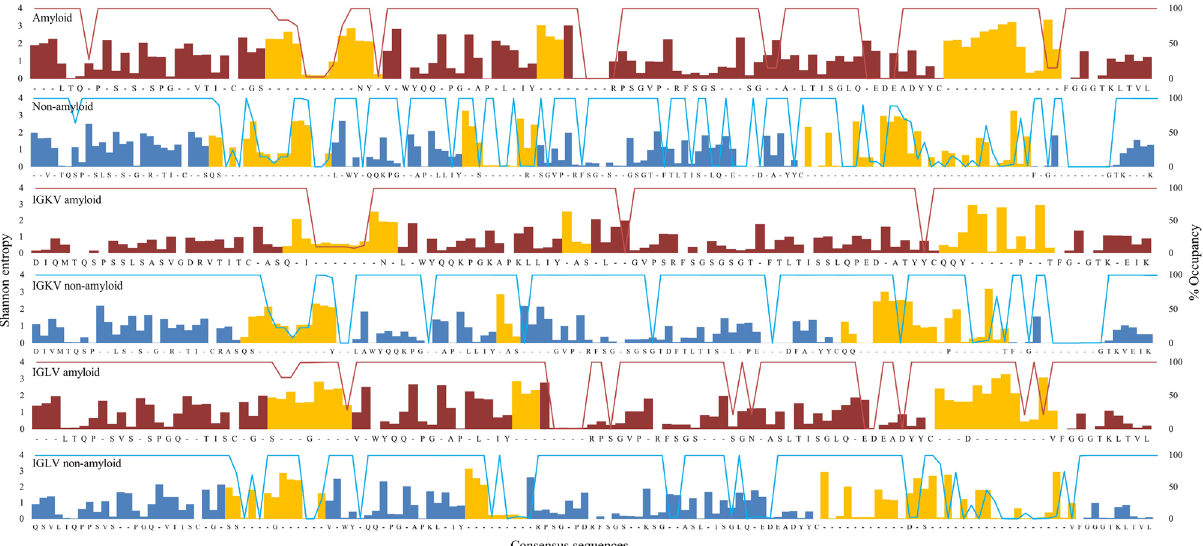
Figure 1. Residue wise Shannon entropy and occupancy plotted for consensus sequences from amyloidogenic (red) and non-amyloidogenic light chains (blue) of complete dataset, kappa (κ) isotype and lambda (λ) isotype. The bar graph shows the Shannon entropy (left axis) and the line graph (right axis) shows the percent occupancy. The CDR regions in the consensus sequence (x-axis) are colored in yellow. Low occupancy values denote more gaps in the multiple sequence